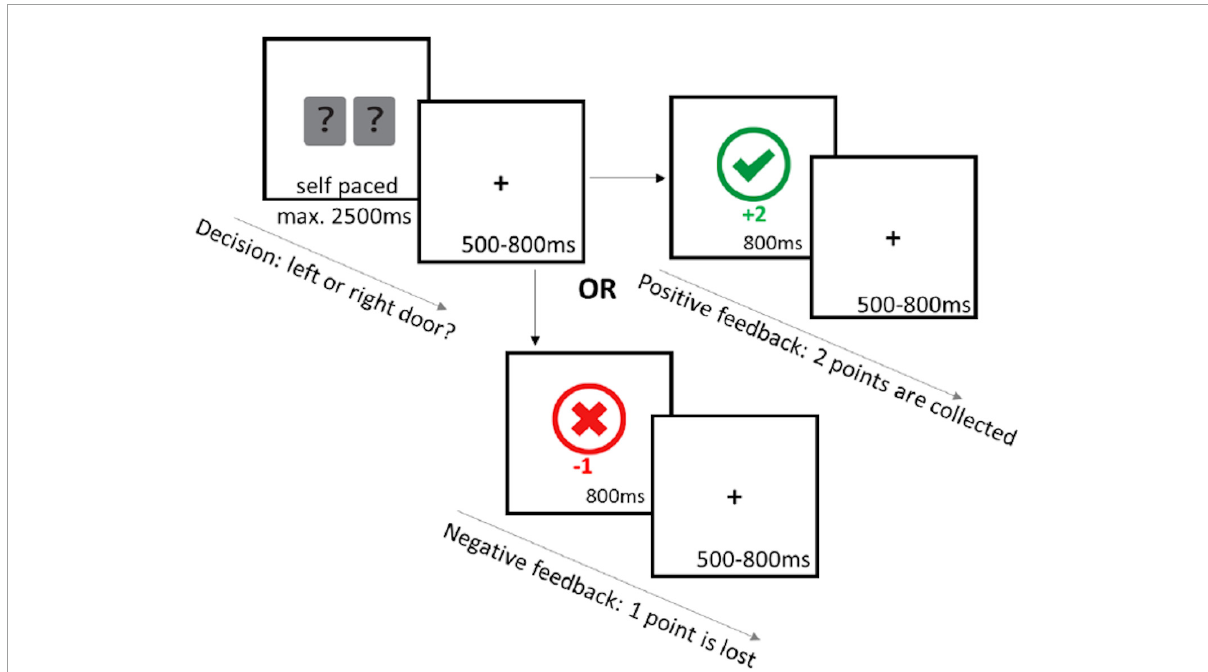
FIGURE1 Schematic showing the guessing task. Participants were presented with two doors for 2,500 ms where they are asked to select a door with the “RIGHT ARROW” to select the right door or the “LEFT ARROW” to select the left door. A fixation cross with a jittered 500–800 ms interval was presented after selection of the door. If the “correct” door was selected participants earned two points and a green check mark appeared. If the “incorrect” door was selected, they lost one point and a red cross appeared. Next trial continues after a jittered 500–800 ms interval.